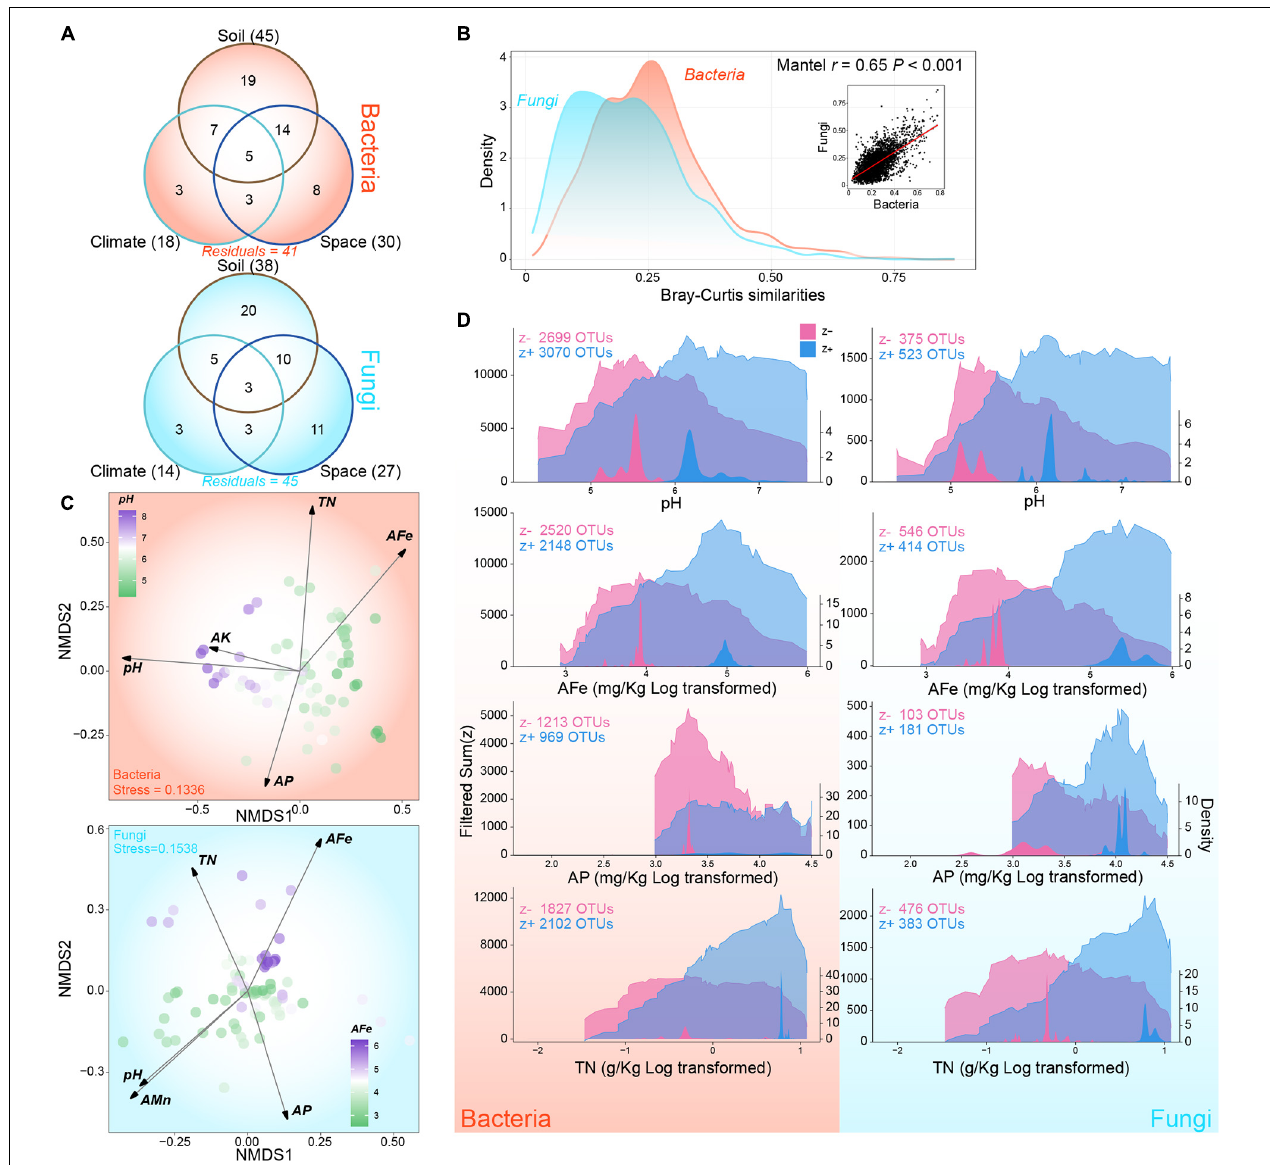
FIGURE 2 | Composition variations and environmental thresholds of rhizosphere bacterial and fungal communities. (A) Variation-partitioning Venn diagram showing the proportions of individual and combined contributions of edaphic, climatic, and spatial factors. Values in brackets indicate the total proportion of variance explained by corresponding partition. (B) The relationship between pair-wise similarities of bacterial and fungal communities based on Bray-Curtis index. Area graphs show the density distribution of bacterial and fungal community similarities. Dot plots represents the correlation between bacterial and fungal community similarities. (C) Global non-metric multidimensional scaling ordination of community composition and fitted key variables of bacteria and fungi. (D) Cumulated community thresholds for key variables of bacteria and fungi. Left axes and the transparent area graph indicate the sum of filtered z– and z + at each change points while right axes and non-transparent area graph represent the density of change points. Variables are log transformed for better visualization as needed. The abbreviations of variables accord to the section “MATERIALS AND